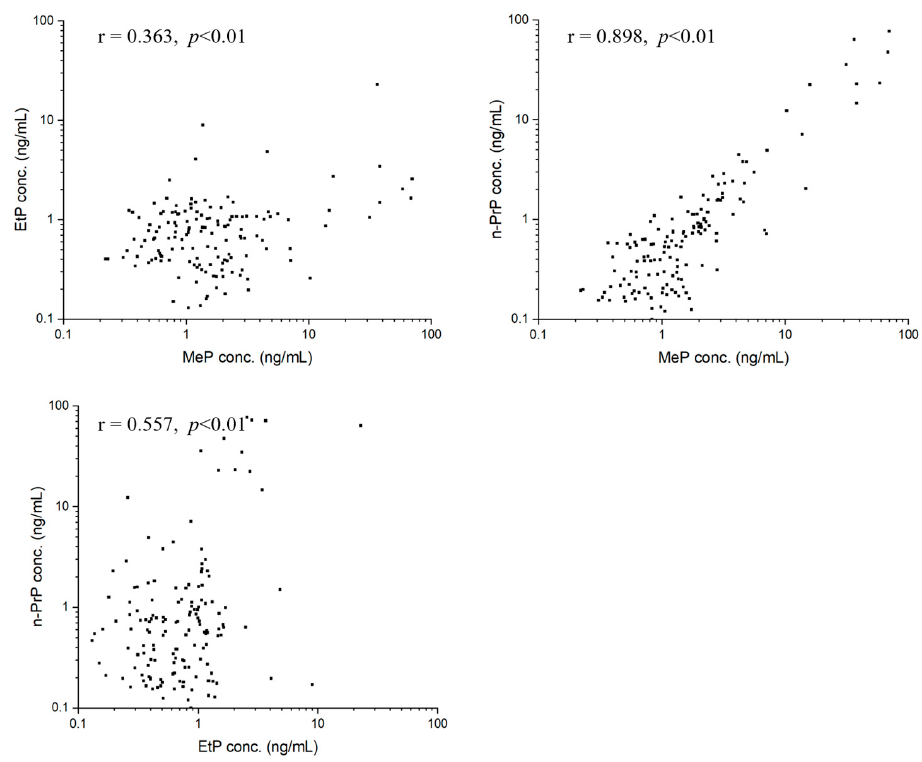
Figure 3. Correlations between MeP and EtP, MeP and PrP, EtP and n-PrP in seminal plasma.